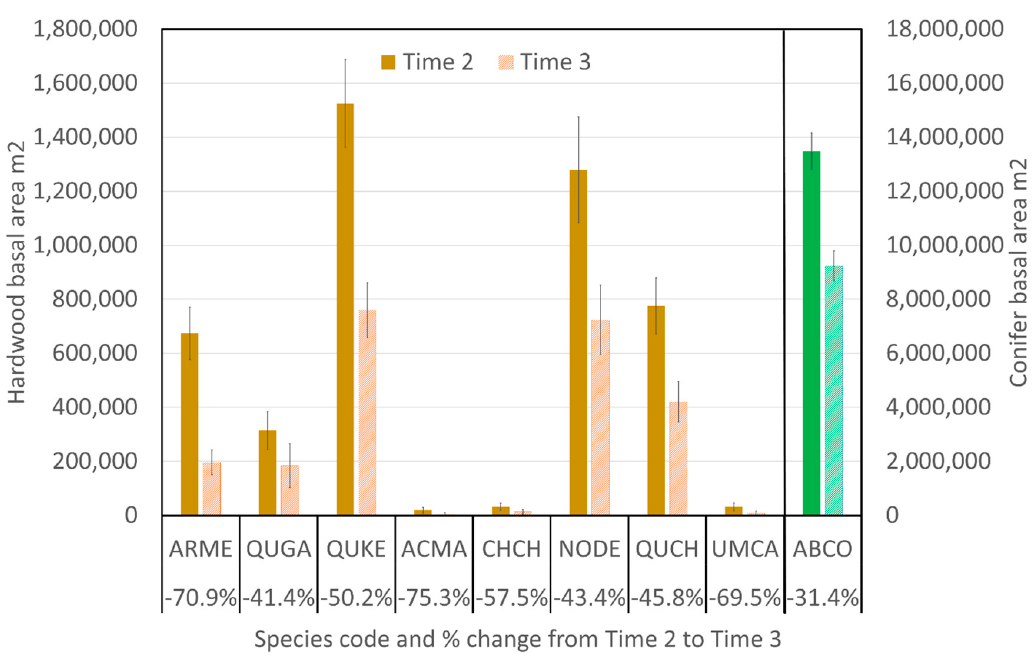
Figure 10. Basal area of trees >28 cm DBH in the open-grown and dominant crown condition categories at times 2 and 3 for eight hardwood species and white fir (on the second Y-axis on the right), with percent reductions labeled (bars are 95% confidence intervals).